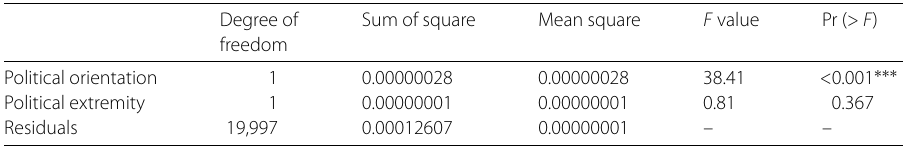
Table 8 ANOVA results to test for correlation of effect of political orientation and extremity with text-based indicators of anxiety Degree of Sum of square Mean square F value Pr (> F ) freedom Political orientation 1 0.00000028 0.00000028 38.41 <0.001 ∗∗∗ Political extremity 1 0.00000001 0.00000001 0.81 0.367 Residuals 19,997 0.00012607 0.00000001 –